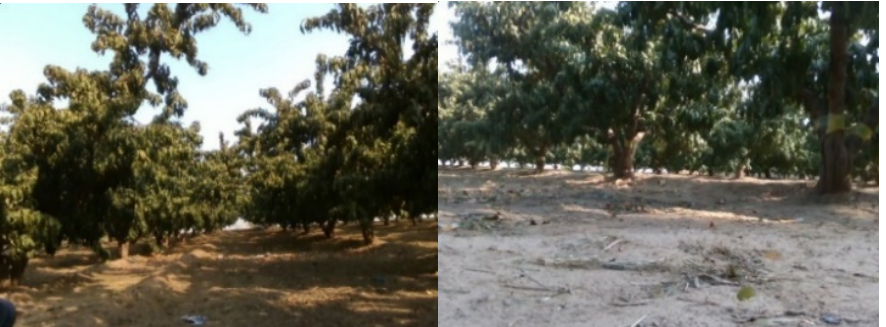
Figure 4. Some examples of the image